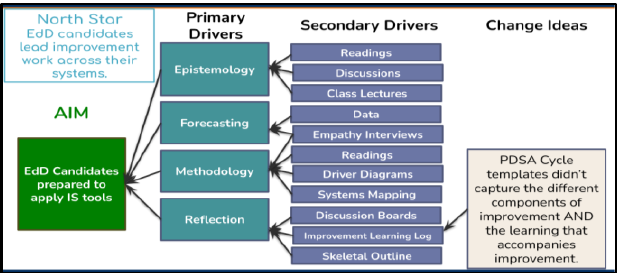
Figure 2. Course Driver